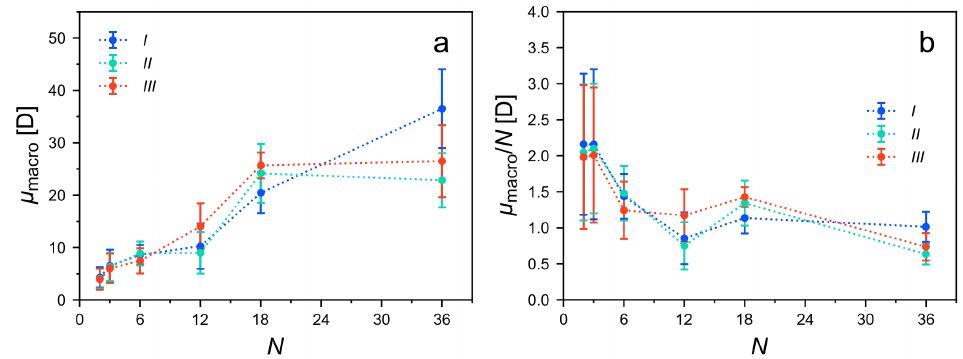
Figure A1. ( a ) Magnitude of the macrodipole moment per stack and ( b ) and magnitude of the dipole moment per monomer in TrisAzo clusters. Both observables are shown as a function of the cluster size N . The considered cluster types are highlighted in different colors. Dotted lines serve as a guide to the